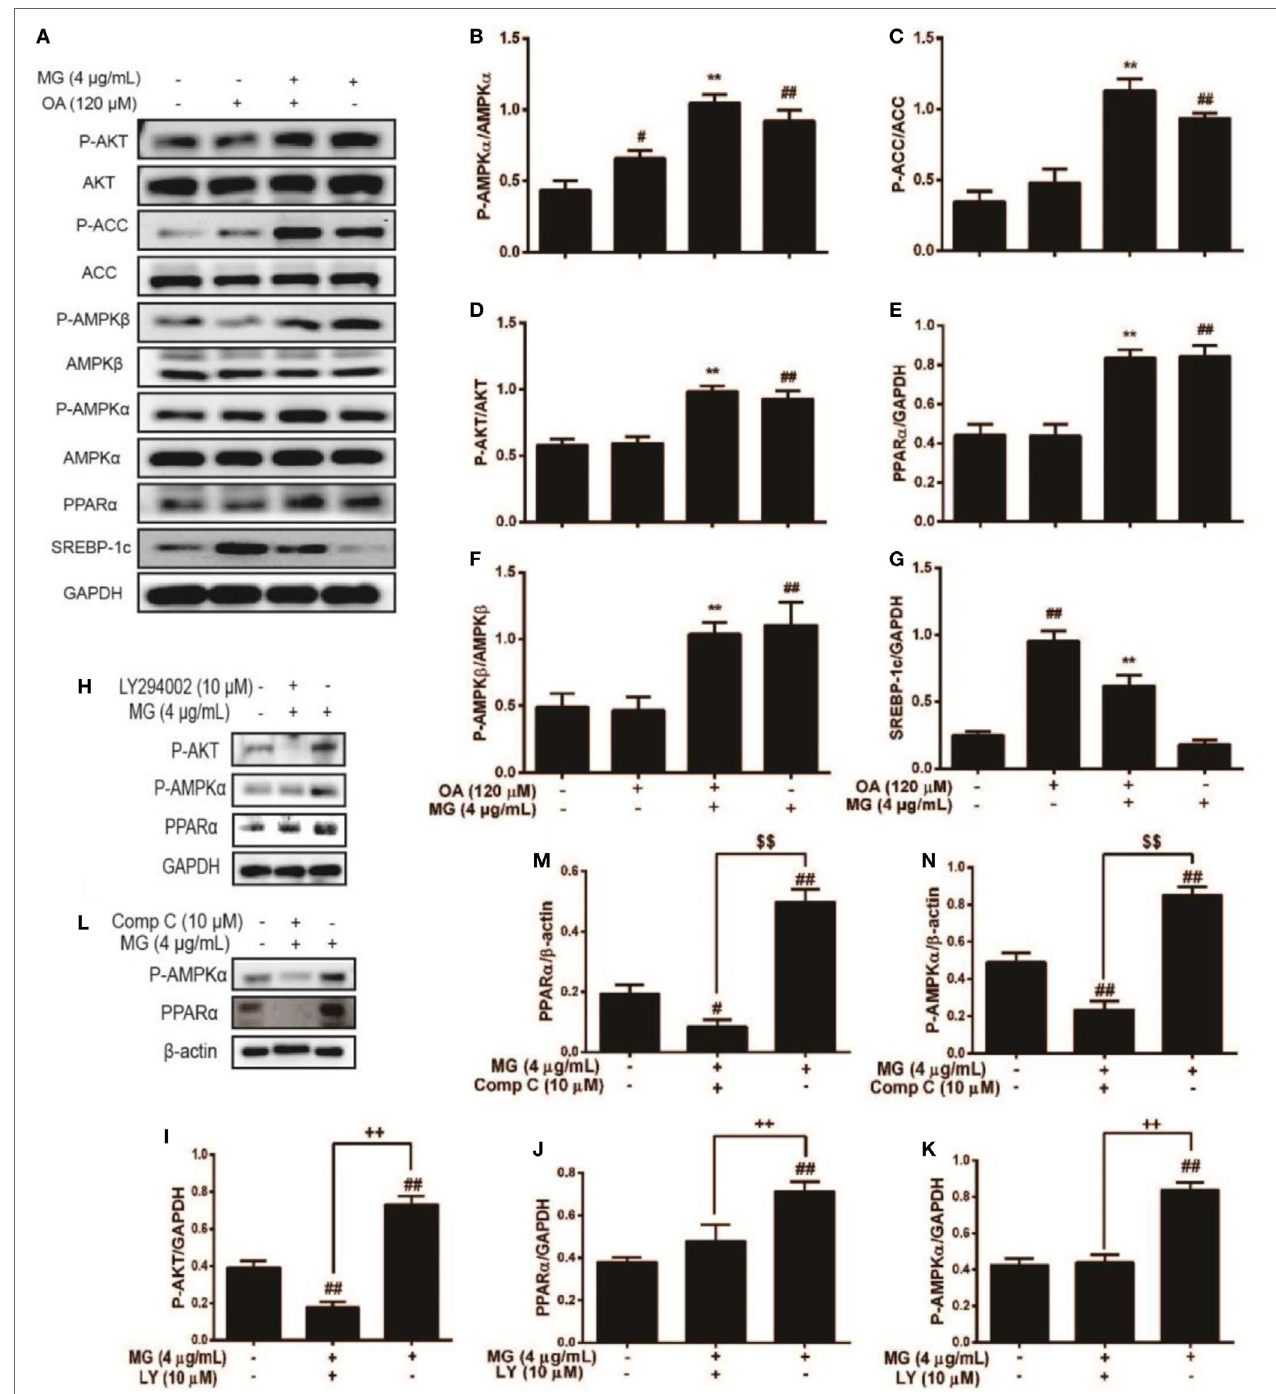
FigUre 4 | Effect of magnolol (MG) regulation of multiple signaling pathways on oleic acid (OA)-induced hepatic steatosis in HepG2 cells. Cells were stimulated by MG (4 µg/mL) with or without OA (120 µM) for 24 h. (a) Protein expression [including P-AKT, AKT, P-acetyl-CoA carboxylase (ACC), ACC, P-AMPK α , AMPK α , P-AMPK β , AMPK β , peroxisome proliferator-activated receptor α (PPAR α ), and sterol regulatory element-binding protein 1c (SREBP-1c)] was analyzed by western blot. (h,l) Cells were pretreated with or without LY294002 (inhibitor of AKT) and compound c (inhibitor of AMPK) for 1 h, followed by incubation with MG (4 µg/mL) for 24 h. (B–g,i–K,M,n) Relative expression levels of all proteins were quantified by density analysis. Analyzed proteins include phosphorylated and total AKT, AMPK α , AMPK β , and ACC. In addition, total PPAR α and SREBP-1c were also detected. Fold induction results were acquired from three independent experiments and are presented as the mean ± SD. Statistically significant at ## p < 0.01 vs. the control group, * p < 0.05 and ** p < 0.01 vs. the OA-treated group, $$ p < 0.01 vs. the compound c-treated group, and ++ p < 0.01 vs. the LY294002-treated group (one-way ANOVA followed by Tukey’s